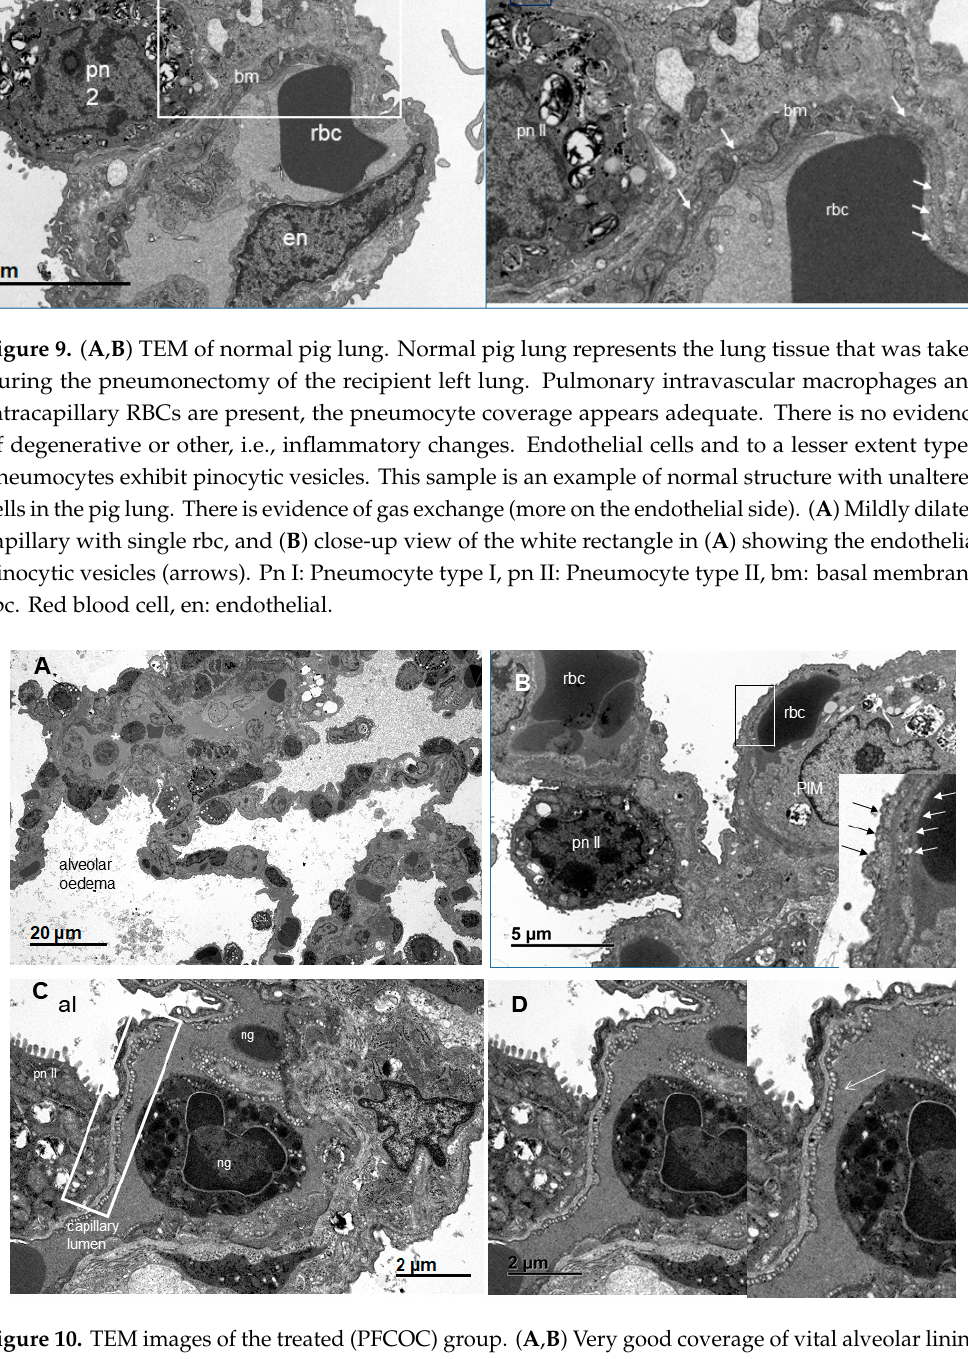
Figure 10. TEM images of the treated (PFCOC) group. ( A , B ) Very good coverage of vital alveolar lining cells, prominent type II pneumocytes, moderate numbers of pulmonary intravascular macrophages (PIMs), and a low number of intracapillary RBCs and neutrophils were observed. There were frequent endothelial pinocytic vesicles that indicated activation and intense transmembranous transport. Vesiculation was also seen in type I pneumocytes. Vesiculation of capillary endothelial cells and type I pneumocytes was obvious. This is interpreted as prominent gas exchange (*): intracapillary leukocyte. ( C , D ) There was distinct vesiculation of capillary endothelial cells, and to a lesser extent, vesiculation was also seen in type I pneumocytes. This was evidence of transmembranous transport / gas exchange. It appeared to be attributable to PFOB treatment, since otherwise endothelial cell vesiculation was only seen in normal lung as shown in Figure